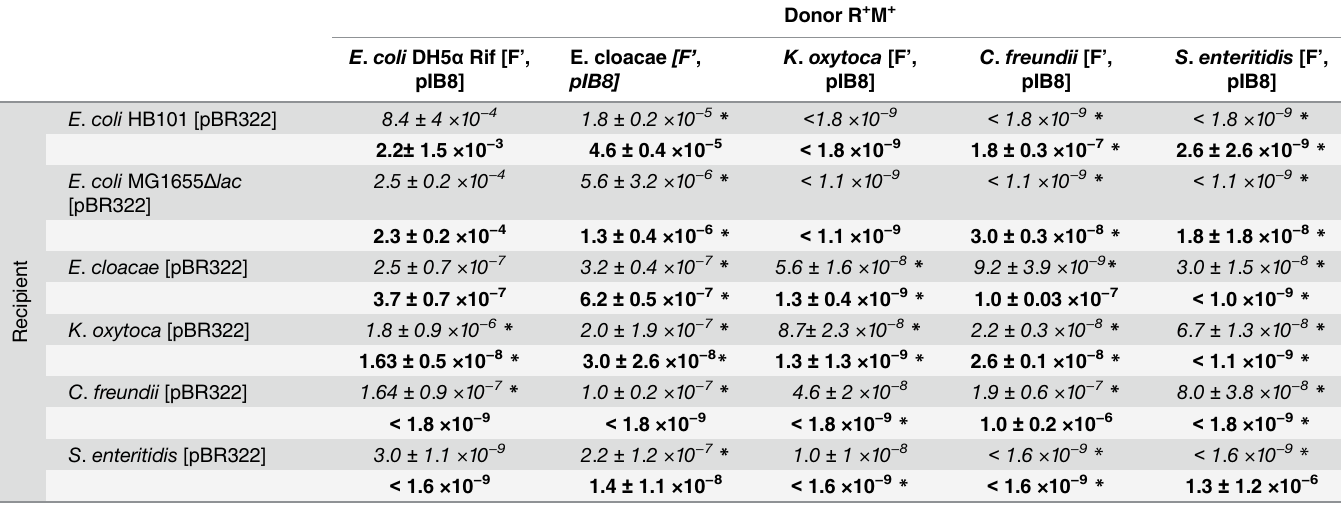
Table 2. Mobilization frequency (italics) of pEC156-derivative pIB8 (EcoVIII R + M + ).